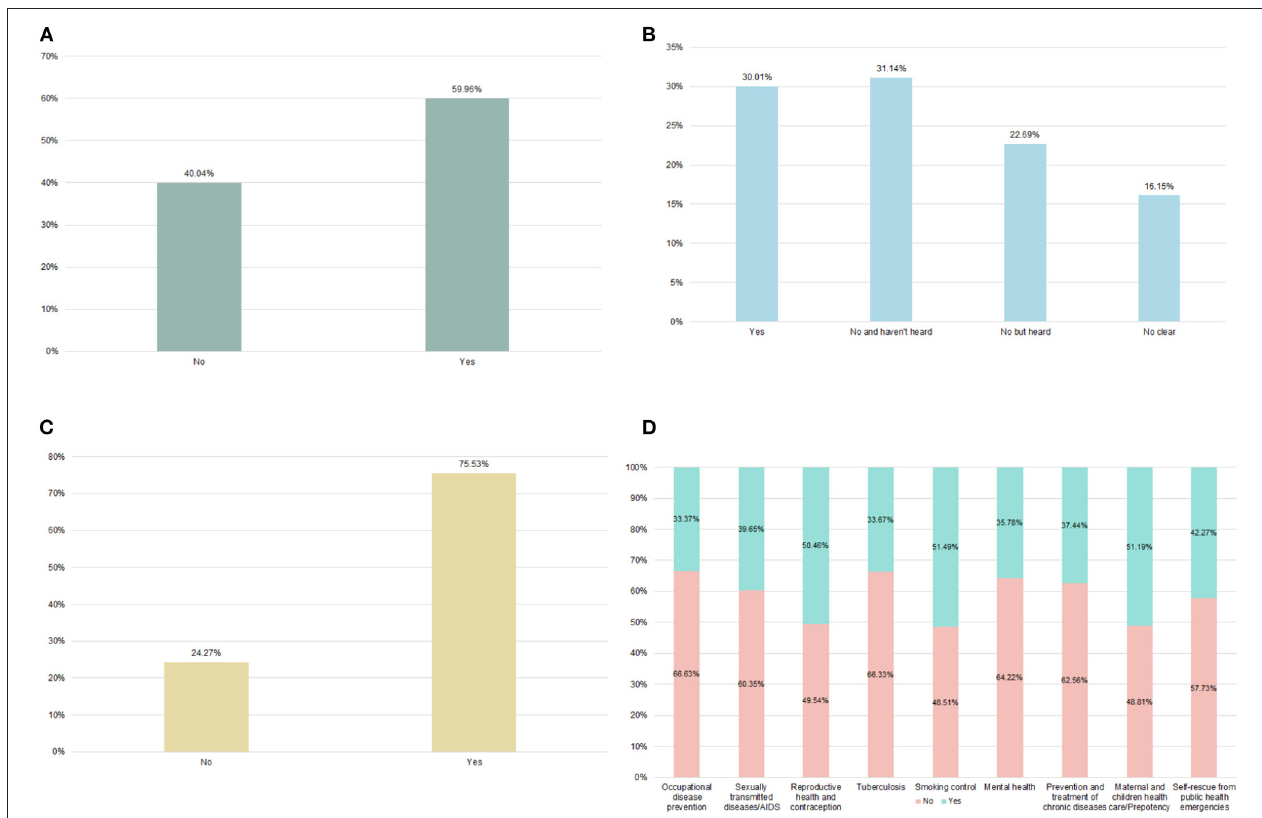
FIGURE 2 | Awareness and utilization of national essential public health services (2017). (A) Awareness of NEPHS (B) Established health record (C) Accepted health education in past year (D) The health education participation rate of different types.